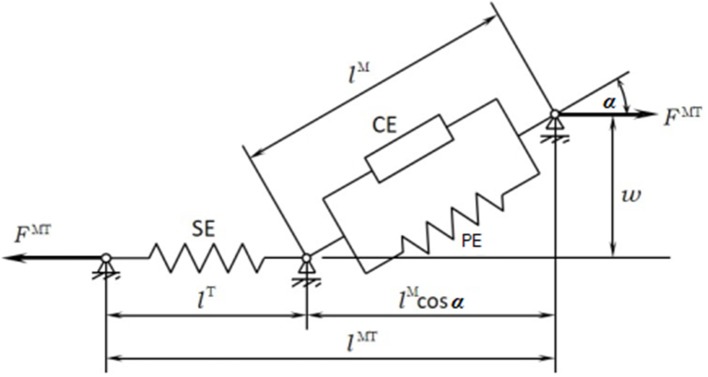
Hill's muscle model.